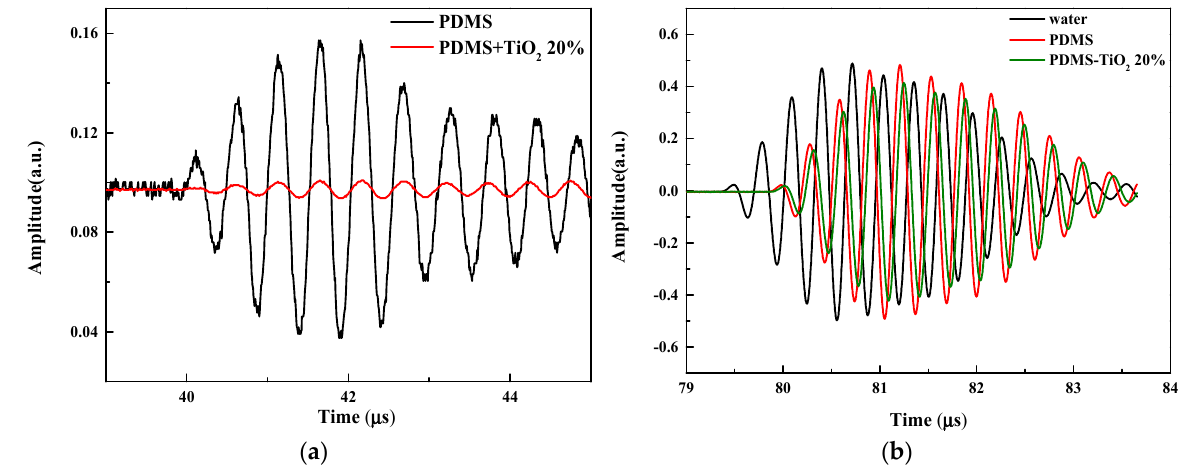
Figure 7. Typical acoustic signals passing through pure PDMS and PDMS with 20% of TiO 2 particles. ( a ) Reflected signals; ( b ) Transmitted signals.